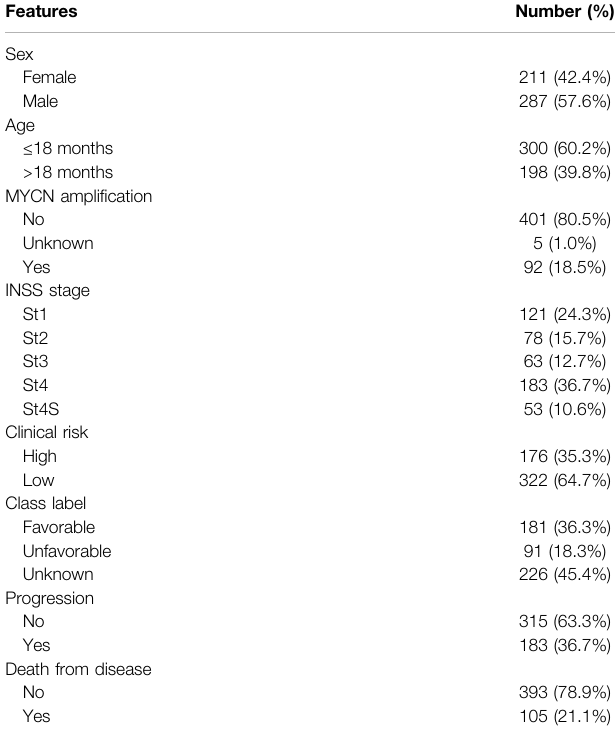
TABLE 1 | Clinical pathological parameters of NB patients in the training set.